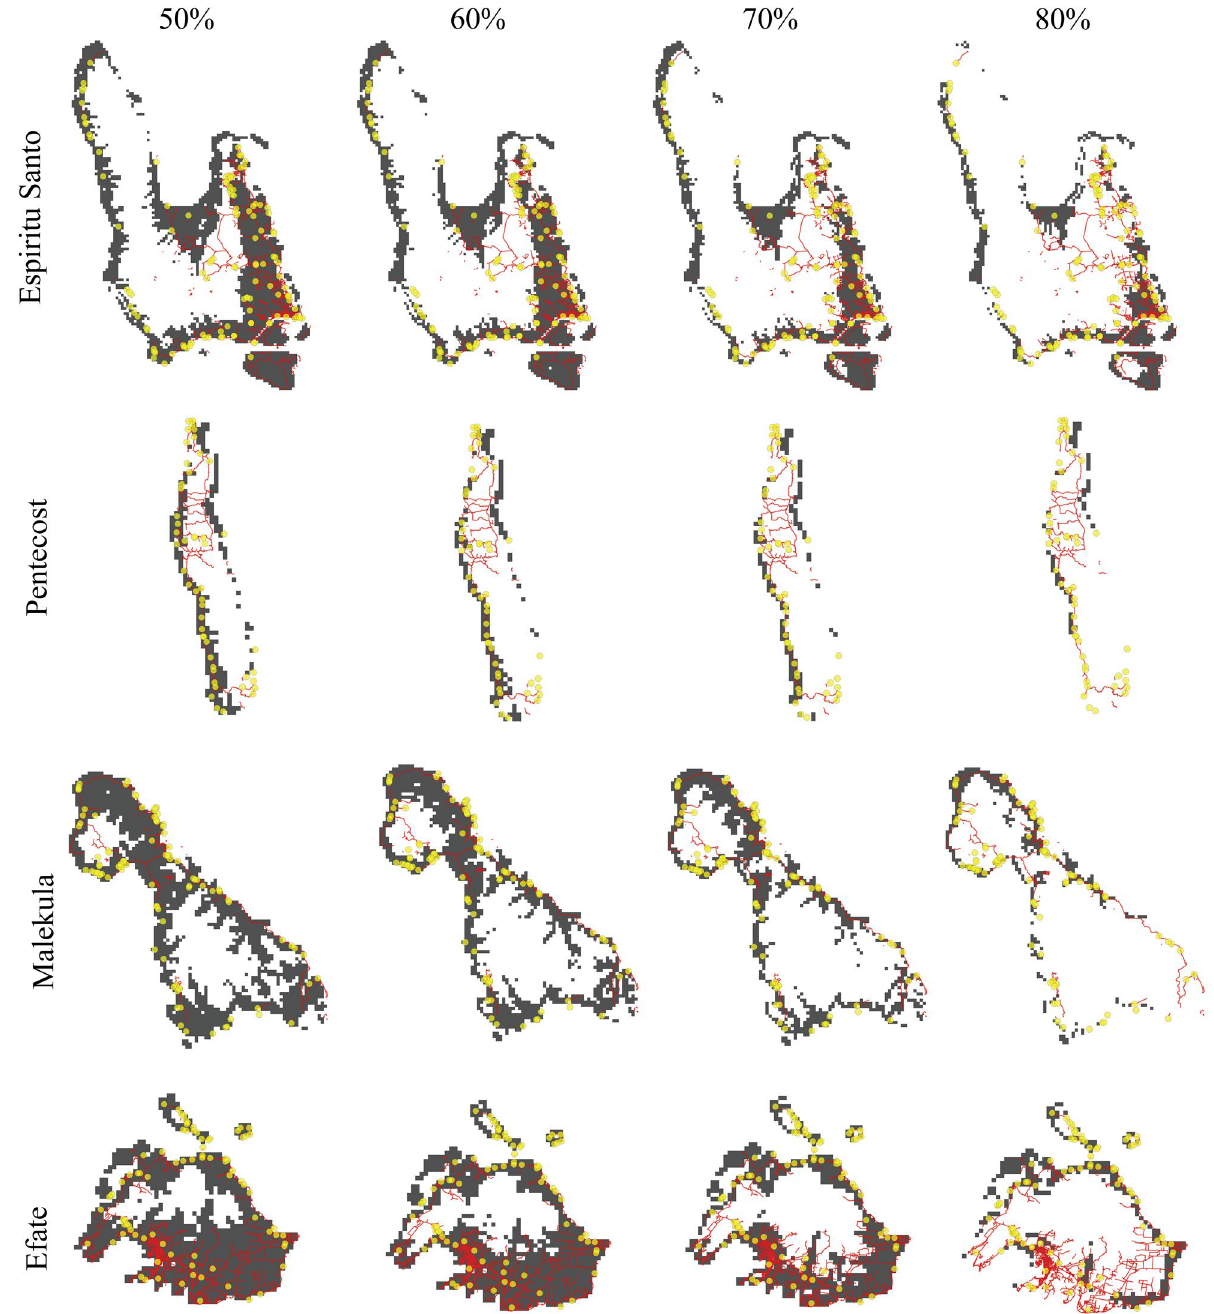
Figure 7. Presence of Atyphella predicted by MaxEnt overlaid with potential bias factors: roads (red), settlements (yellow). Rows are four heavily sampled islands, columns are thresholds of predictive results (i.e., 0.6 are those areas predicted to have Atyphella with > 0.6 probability in the combined model) (MaxEnt version 3.3.3 k, QGIS Zanzibar 3.8, NextGIS: https:// data. nextg is. com/ en/ region/ VU/, Adobe, San Jose, CA,